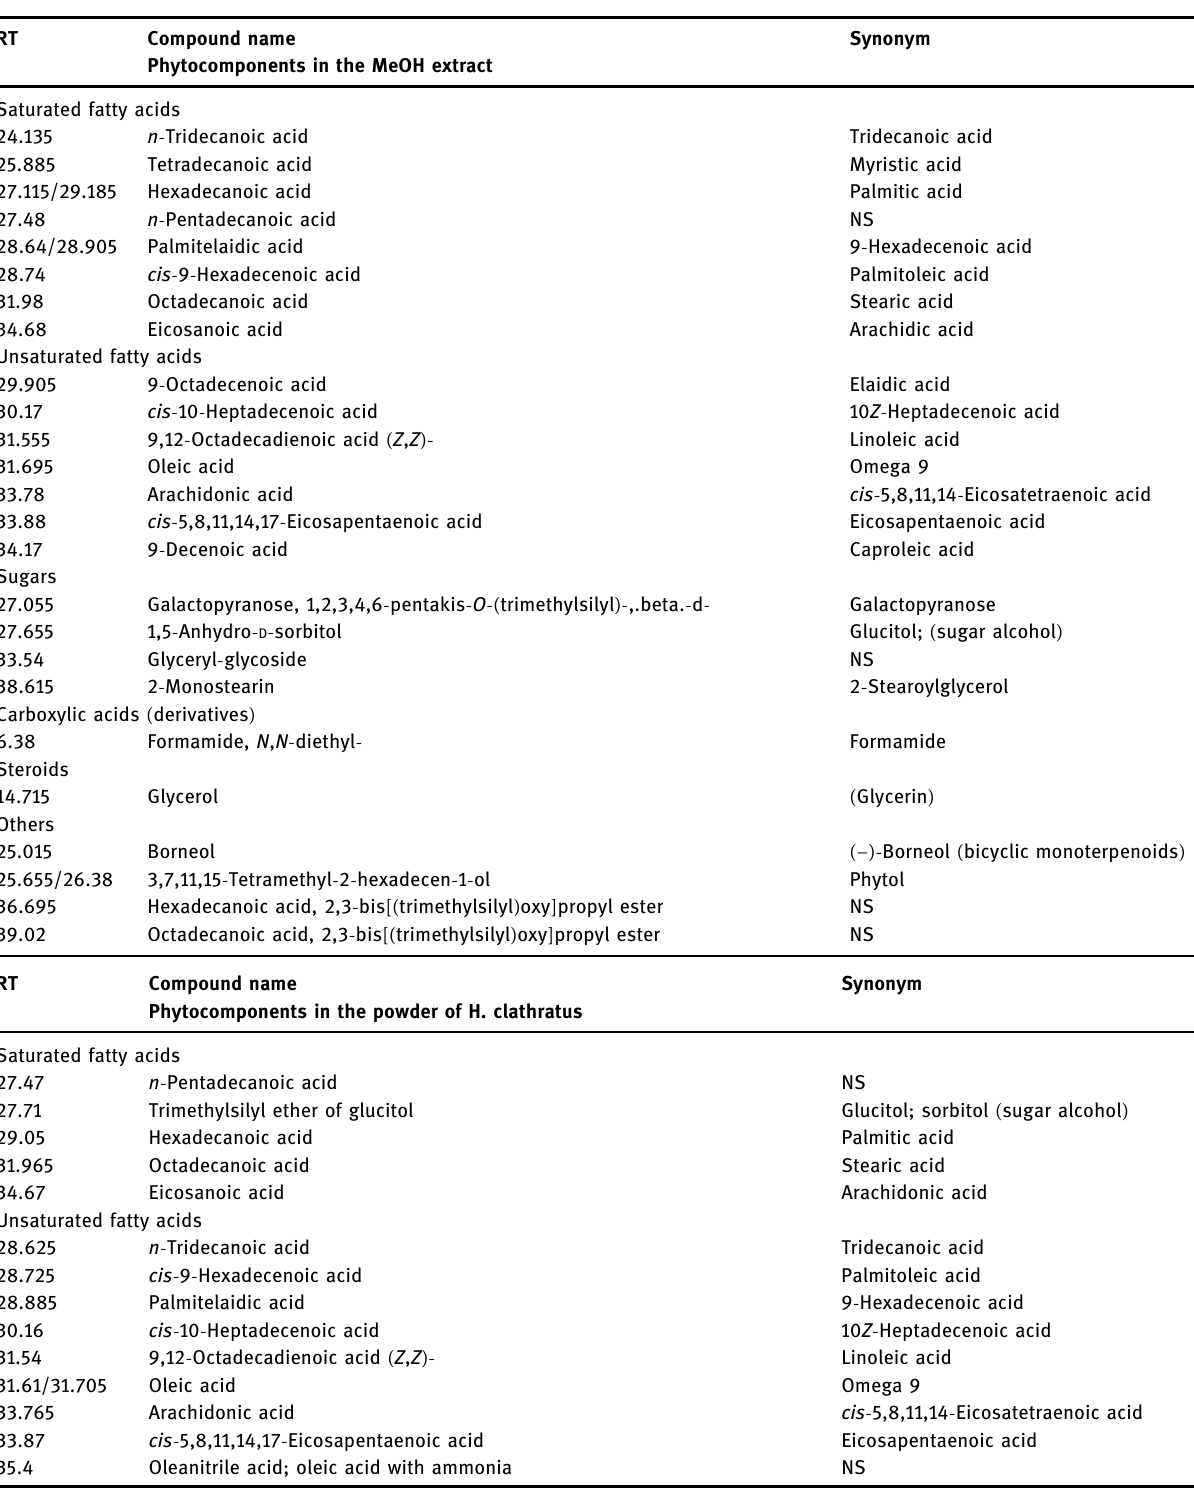
Table A1: Phytochemicals identi fi ed in the MeOH extract and powder of H.